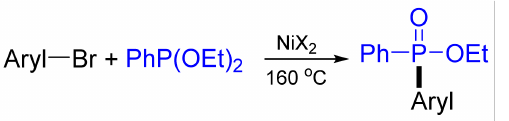
Figure 24. Ni-catalyzed reaction of phosphonic ethers with aryl bromides.